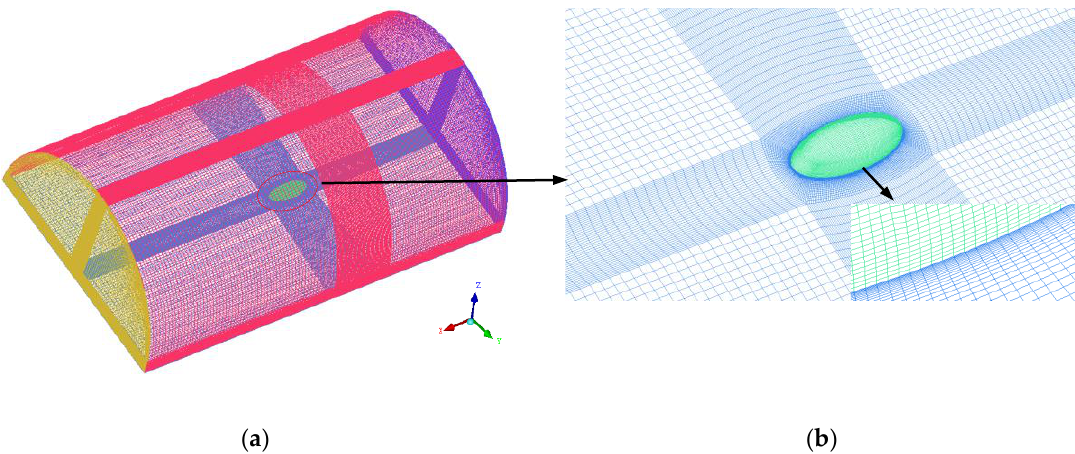
Figure 2. (a) Sketch map of the external domain mesh ; (b) Sketch map of the internal domain mesh. Figure 2. ( a ) Sketch map of the external domain mesh; ( b ) Sketch map of the internal domain mesh.